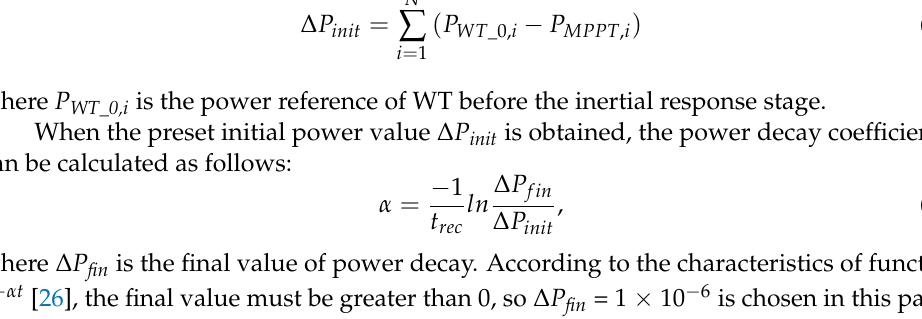
Figure 10. SFD active suppression control for HVDC.